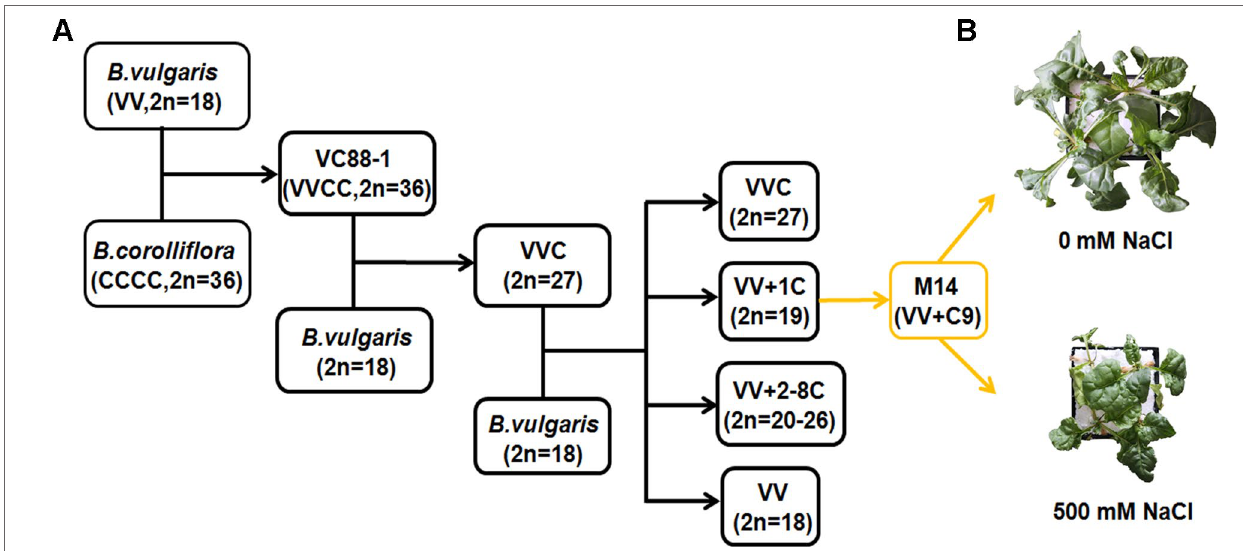
FIGURe 1 | Generation of sugar beet M14 and its phenotype under salt stress. (A) Breeding process of sugar beet M14 ( B. vulgaris genome plus chromosome No. 9 from B. corolliflora ). (B) Growth status of sugar beet M14 under salt stress for seven days.